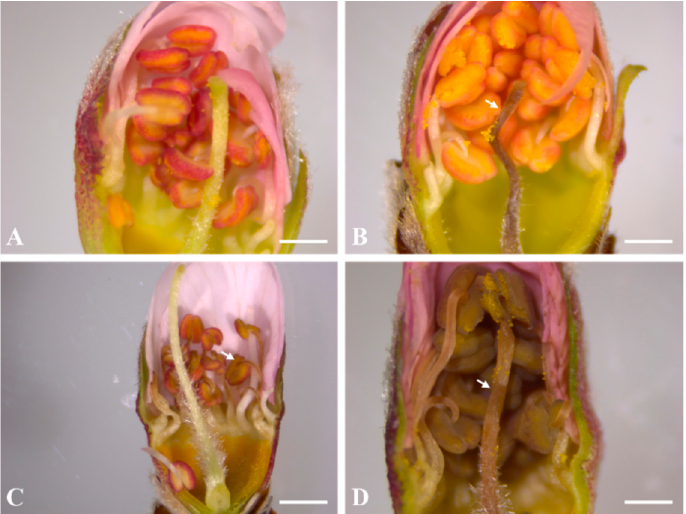
Figure 5. Representative visuals of damage to the peach flower buds caused by spring frost simula- tion using an SFDS chamber. Browning of each reproductive organ was evaluated by examining the transverse section of a peach flower bud ( A – D ). ( A ), no damaged; ( B ), only pistil damaged; ( C ), only stamen damaged; and ( D ), pistil + stamen damage. The scale bars are 500 µm in ( A , B , D ) and 400 µm in ( C ).